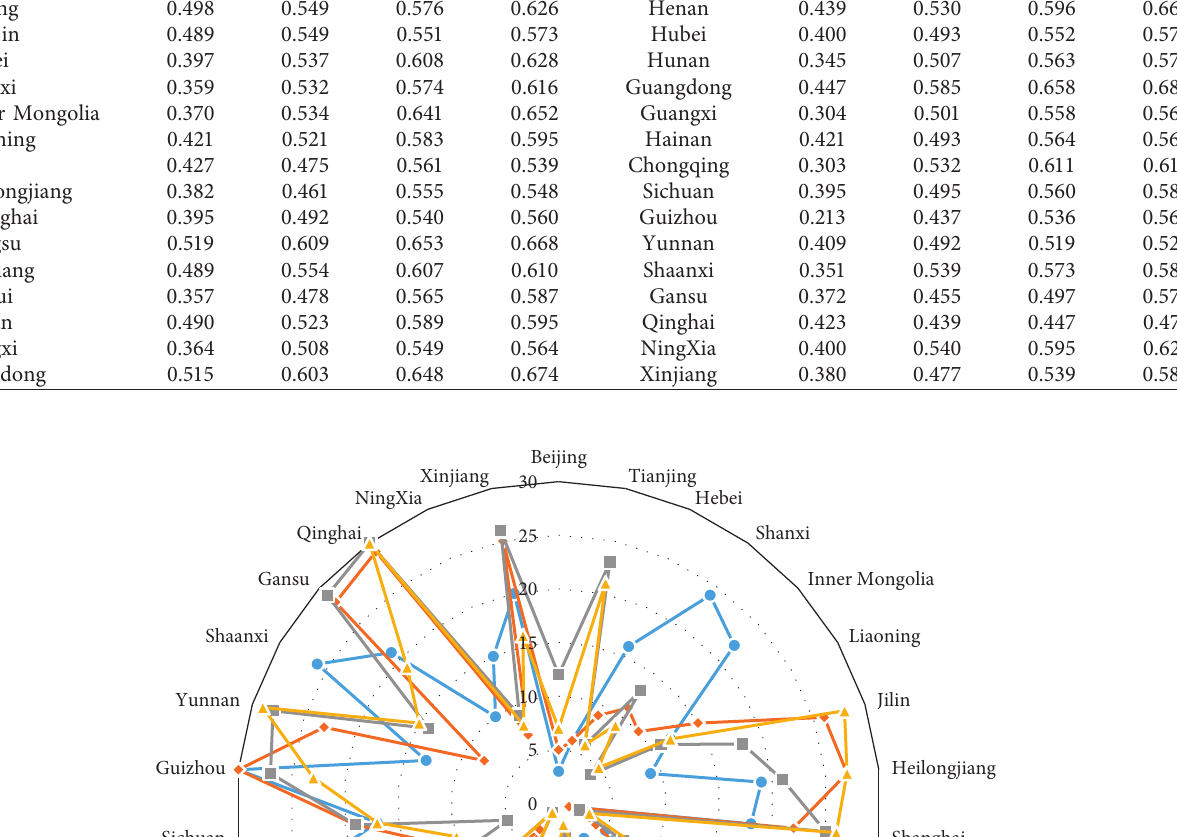
Table 6: The comprehensive index of ER subsystem in 2004, 2010, 2015, and 2017. Province